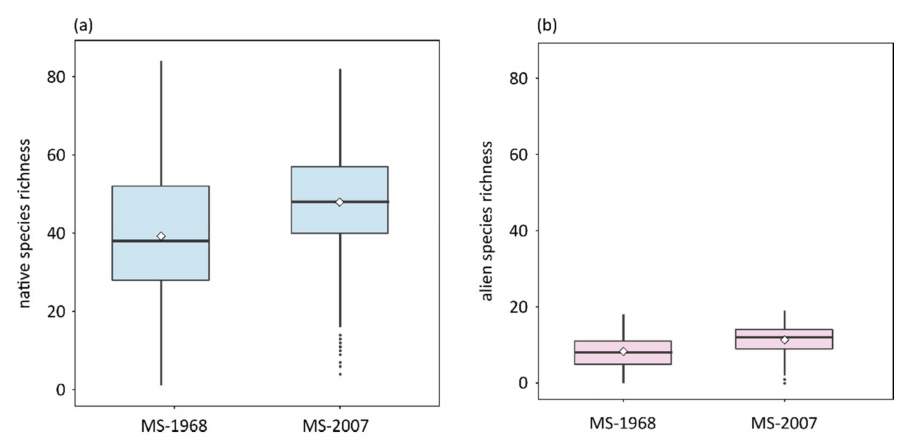
Figure 2. Boxplots of ( a ) native and ( b ) alien species richness in the first (MS-1968) and the second (MS-2007) time period of breeding birds of Massachusetts per grid cell (grid cell size approximately 25 km 2 ). Diamonds and lines depict mean and median values,